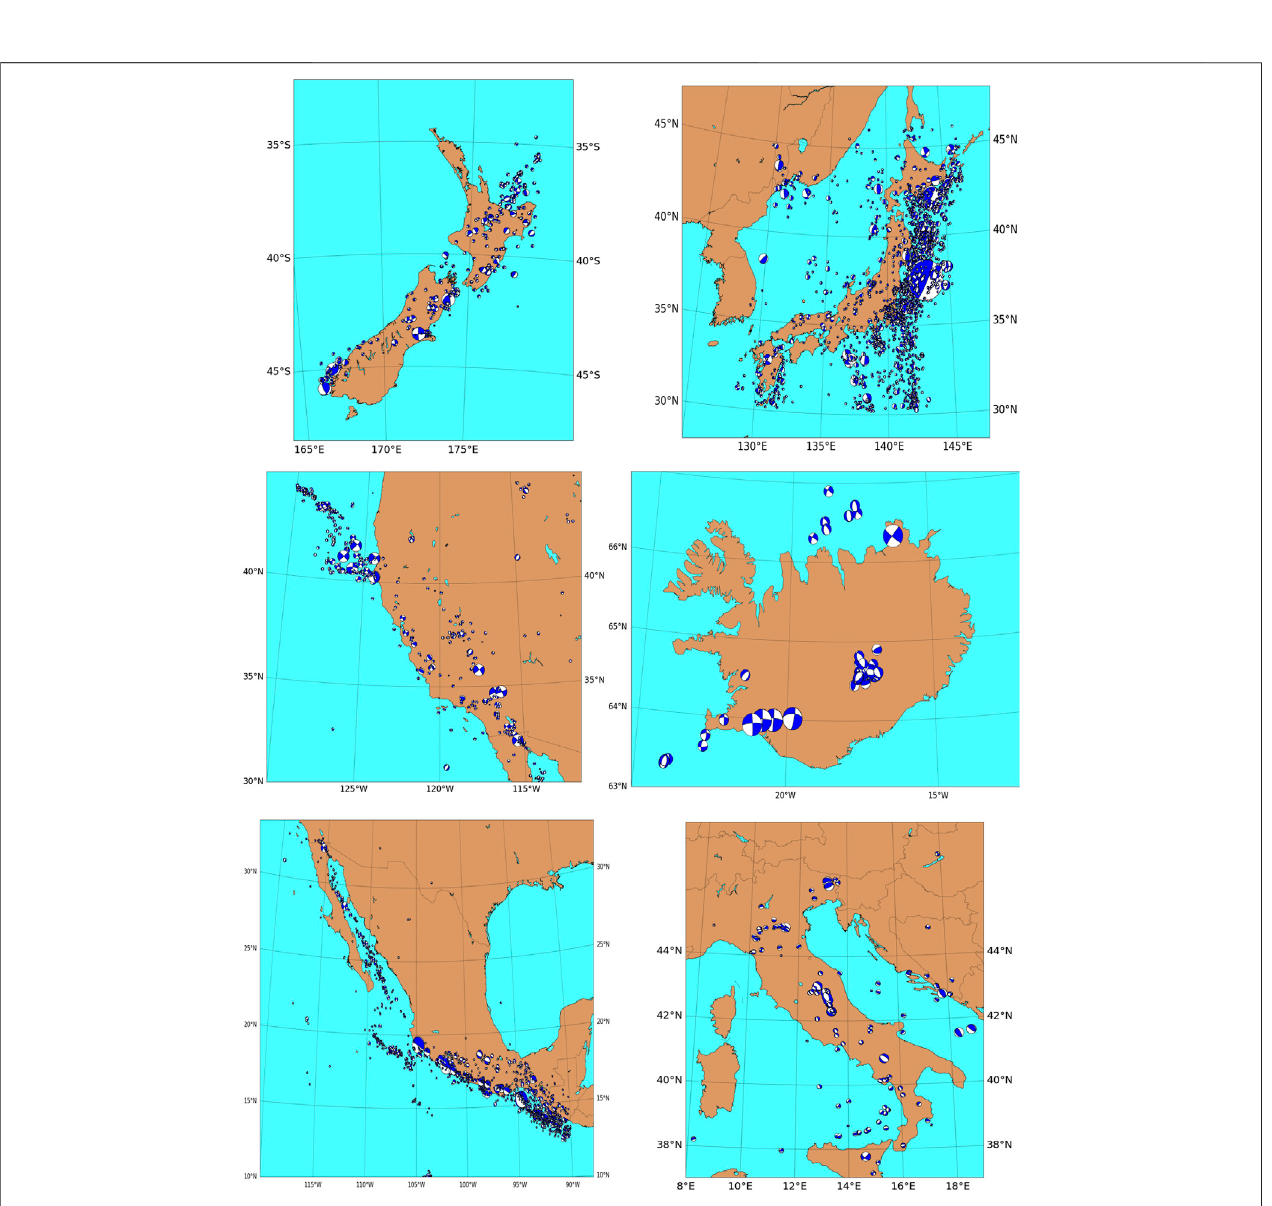
FIGURE 1 | GCMT datasets used in this study (see Table 1 ), the epcientral locations, and the FM solutions are shown.